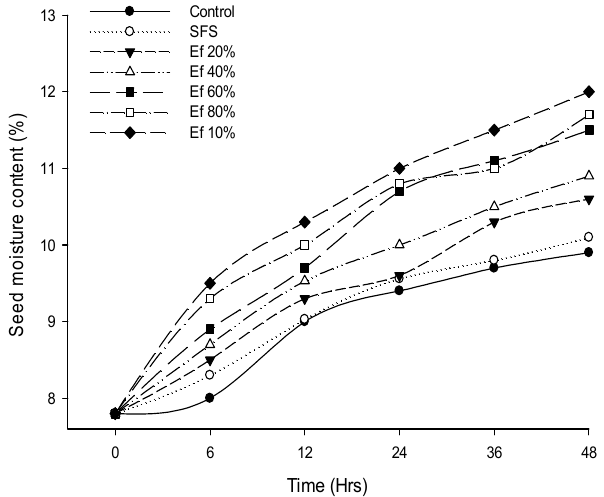
Figure 10. Effect of EF-LSEs on seed imbibition capabilities of tomato seeds. Figure 10. E ff ect of EF-LSEs on seed imbibition capabilities of tomato